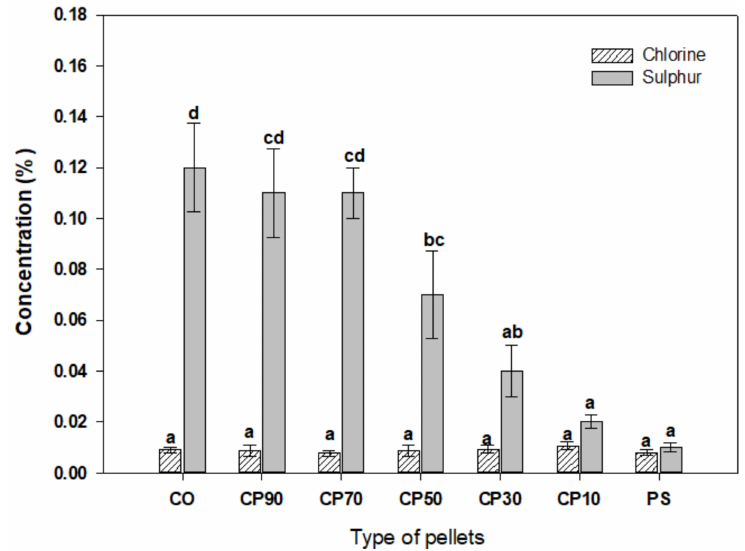
Figure 9. S and Cl concentrations of pellets according to SCG blending ratio. Each point is the mean of three repeated measurements and is the mean ± standard deviation. The means with different letters (a–d) above the bars indicate significant differences based on Tukey’s HSD test ( p <